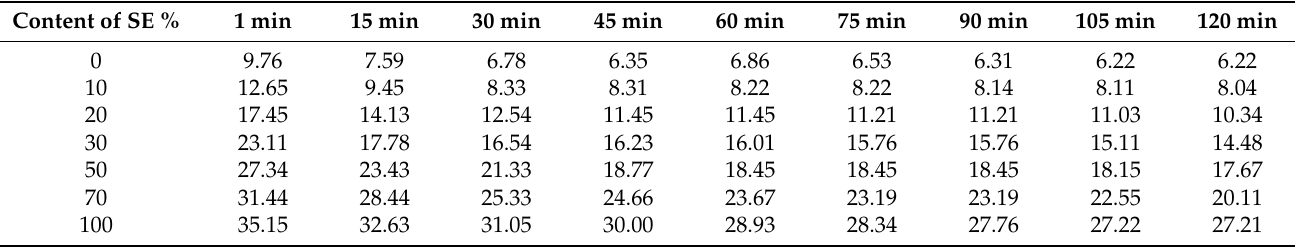
Figure 5. ( a ). Effect of SE concentration on oil–water interfacial tension; ( b ). Effect of demulsifier concentration on oil–water interfacial tension of mixed emulsion when SE content is 30%. Table 6. Effect of SE concentration on oil–water interfacial tension.